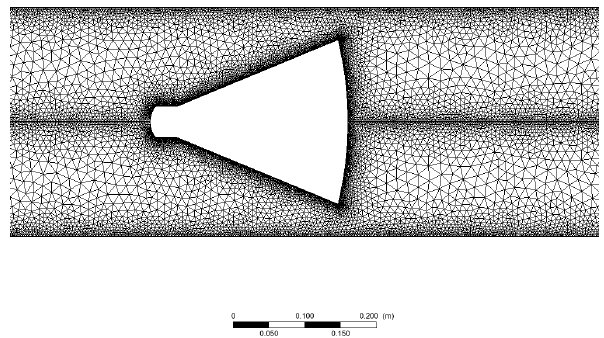
Figure 6. Unstructured mesh for the S-G